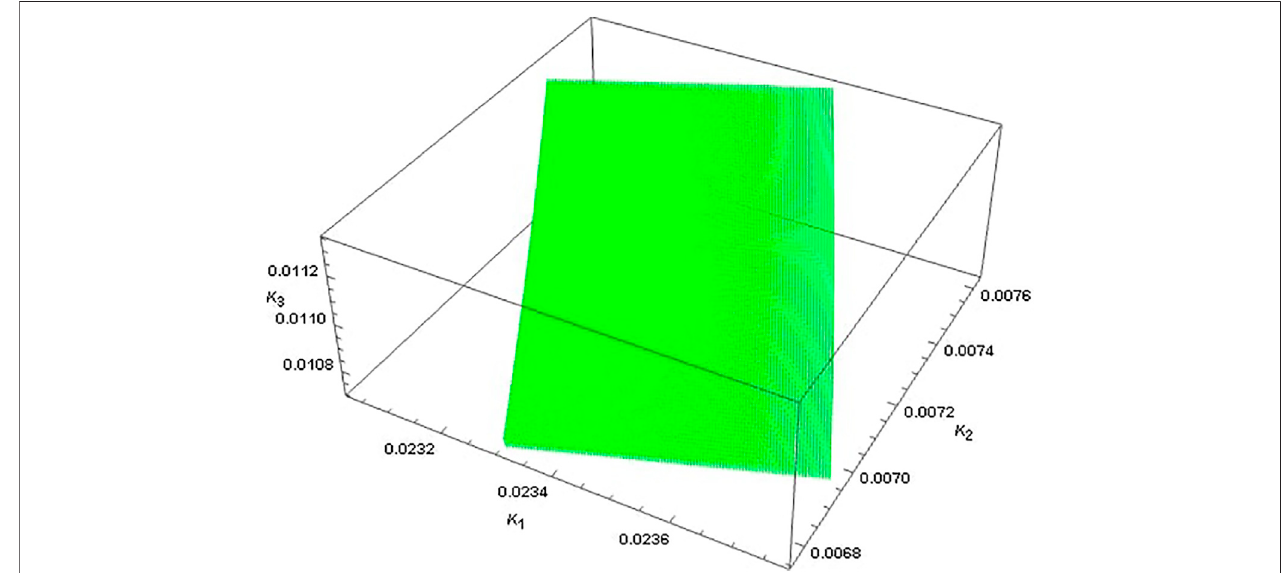
FIGURE 1 | Correlation plots for the model parameters (in eV).